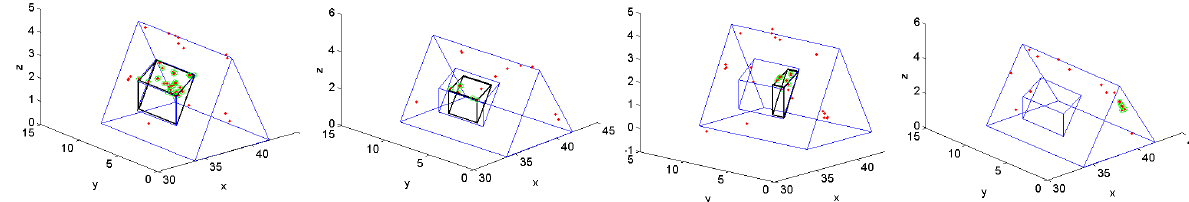
Figure 12. Reconstruction of a shed dormer with different point densities: from left to right 11, 5.5, 4.4 and 3.3 points/ m 2 . Recon- structed dormer (black). MSE and inclination based clustering results (red). Clustered region after new clustering of the red points based on their 3D coordinates